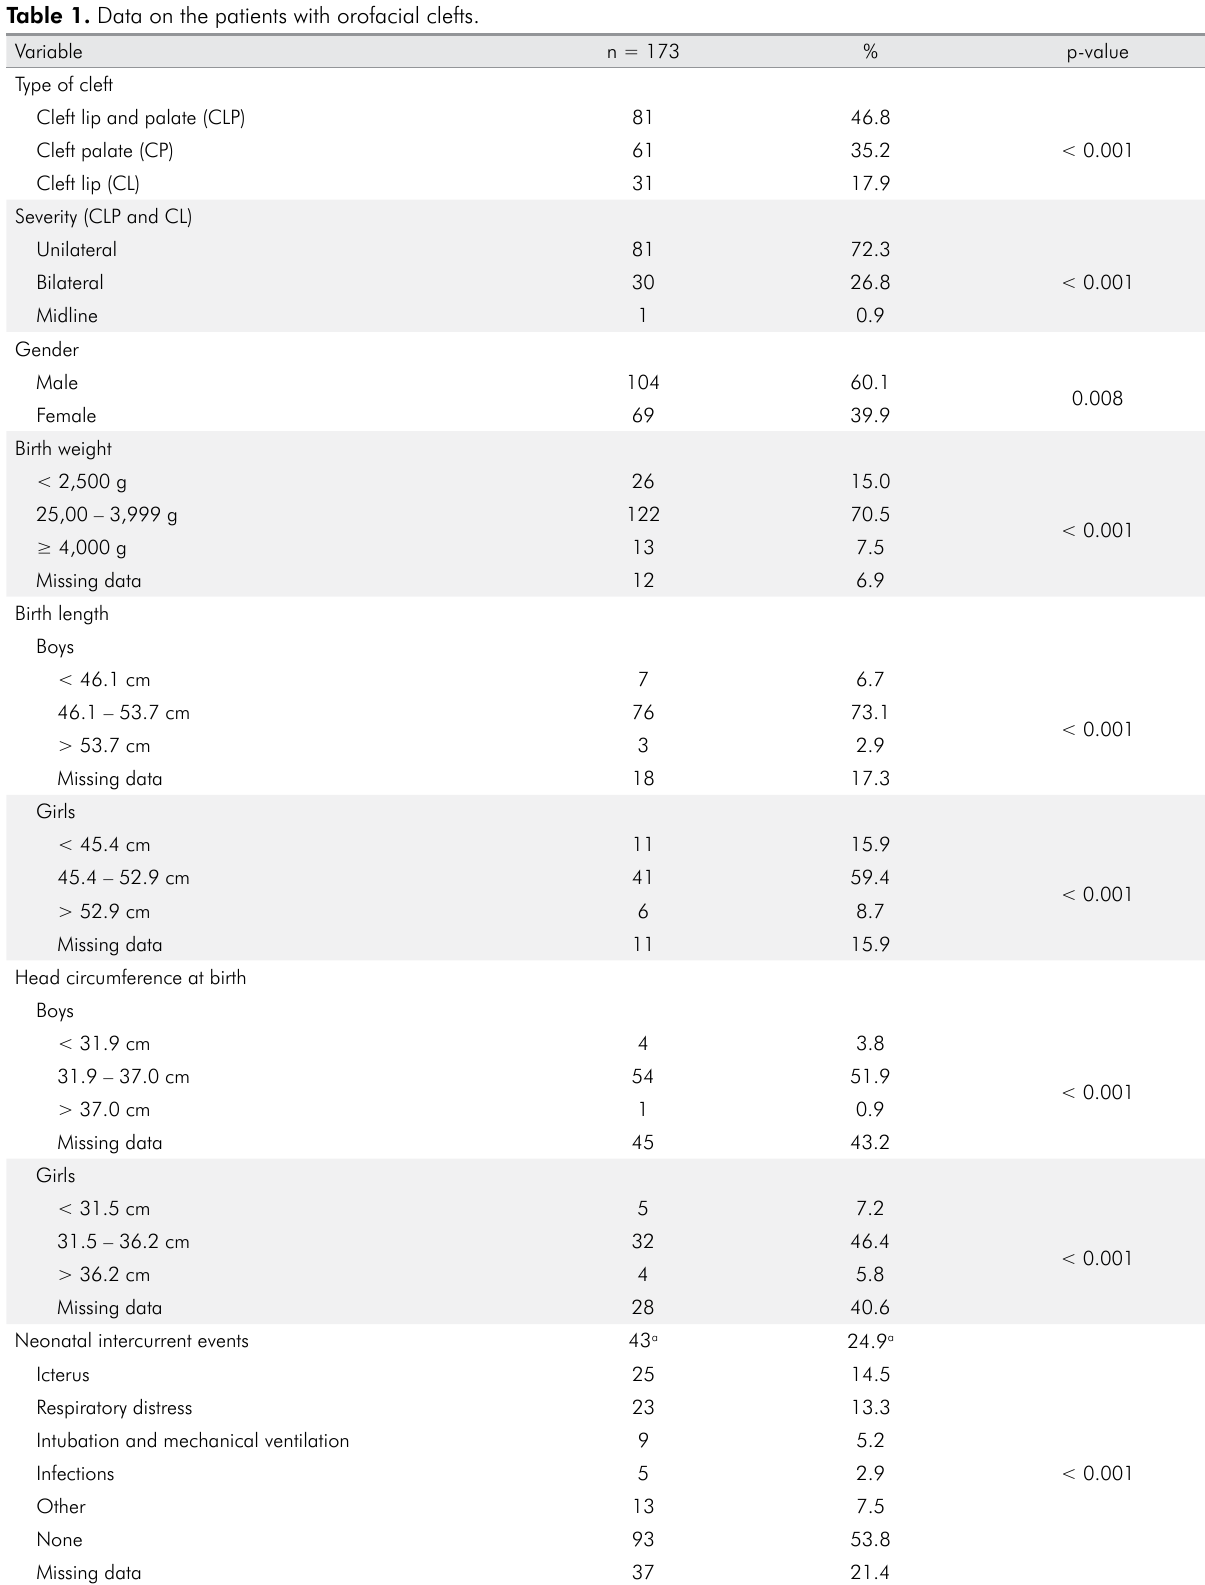
Table 1. Data on the patients with orofacial